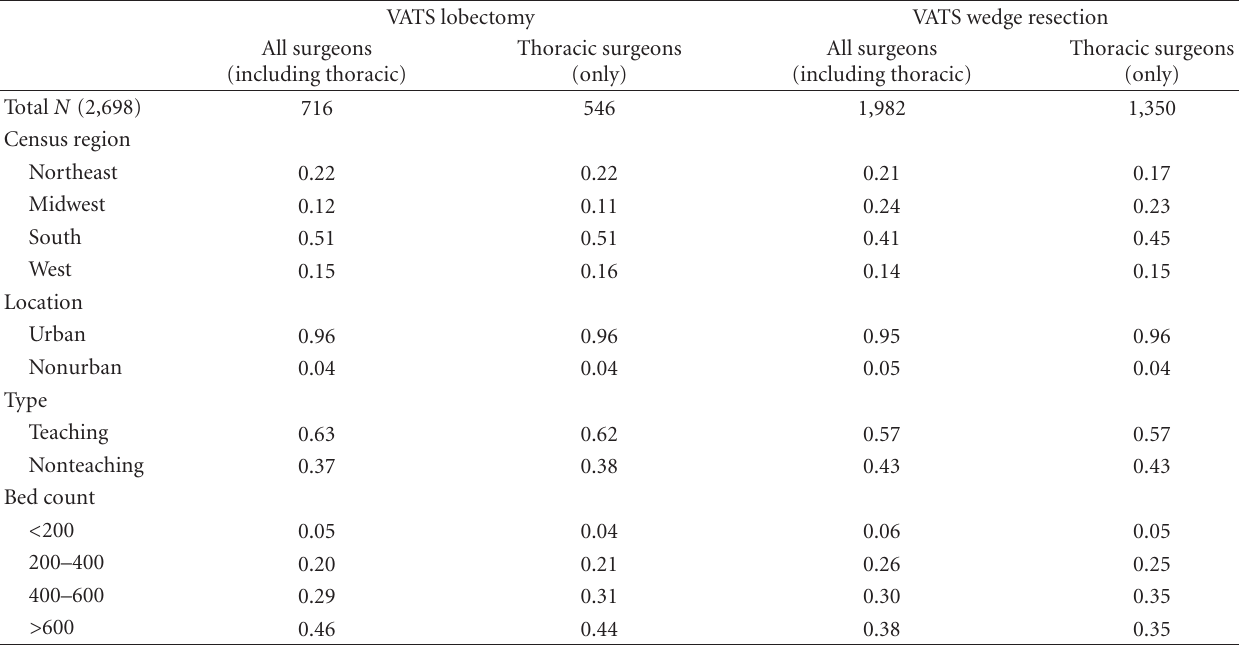
Table 3: Hospital